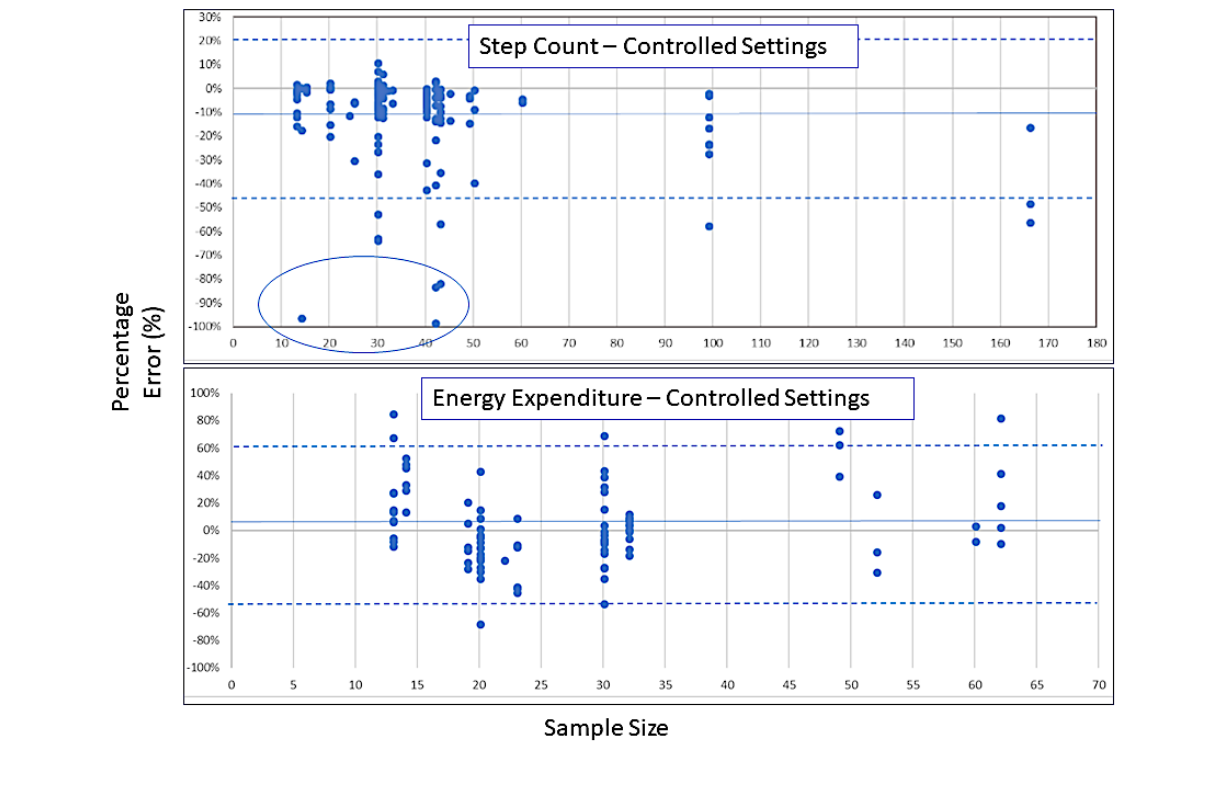
Figure 2. Percentage error distribution by sample size. Top: Step count in controlled settings. The blue oval indicates extreme outliers (n=4 comparisons). Bottom: Energy expenditure in controlled settings. Solid blue lines indicate mean error estimation. Dotted blue lines indicate 95%